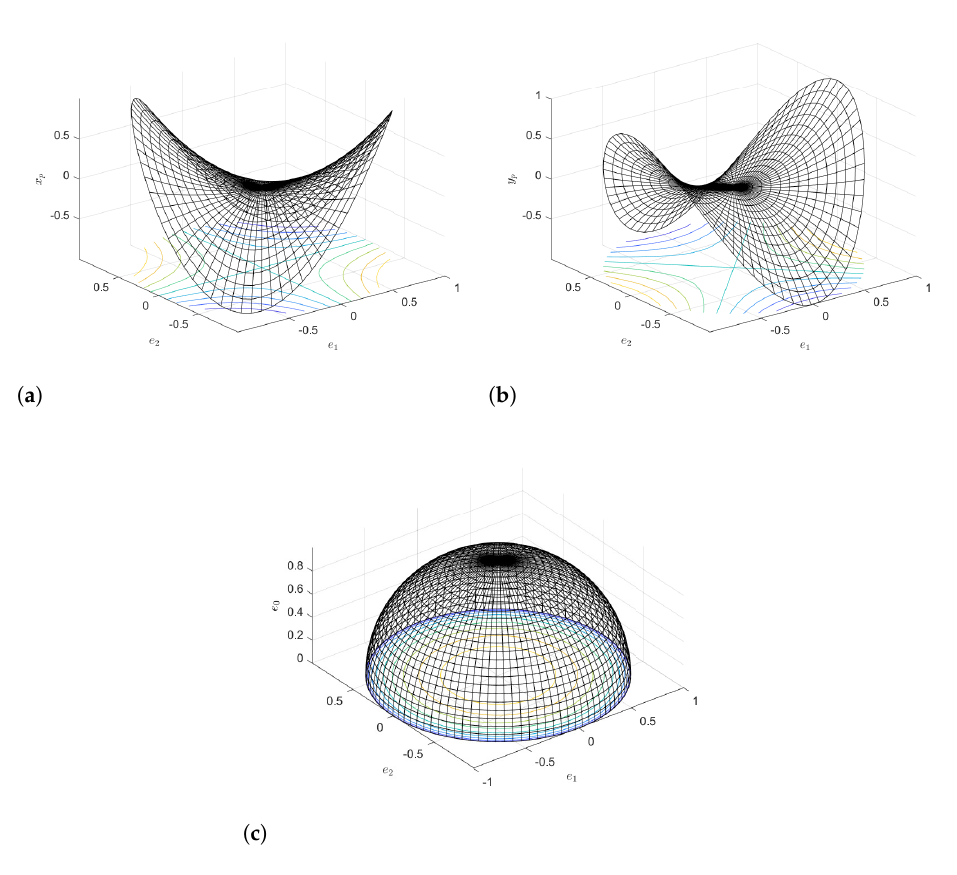
Figure 4. 3 PRS parasitic motions: ( a ) x P , ( b ) y P , ( c ) e 0 . Dot-multiplying Equation (14) by ( b i − c i ) , we get rid of ω i , obtaining a relationship between velocity inputs and velocity